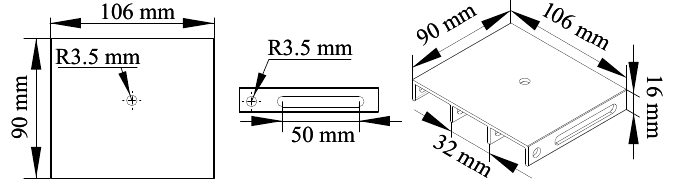
Figure 7. Drawing of the upper board structure.